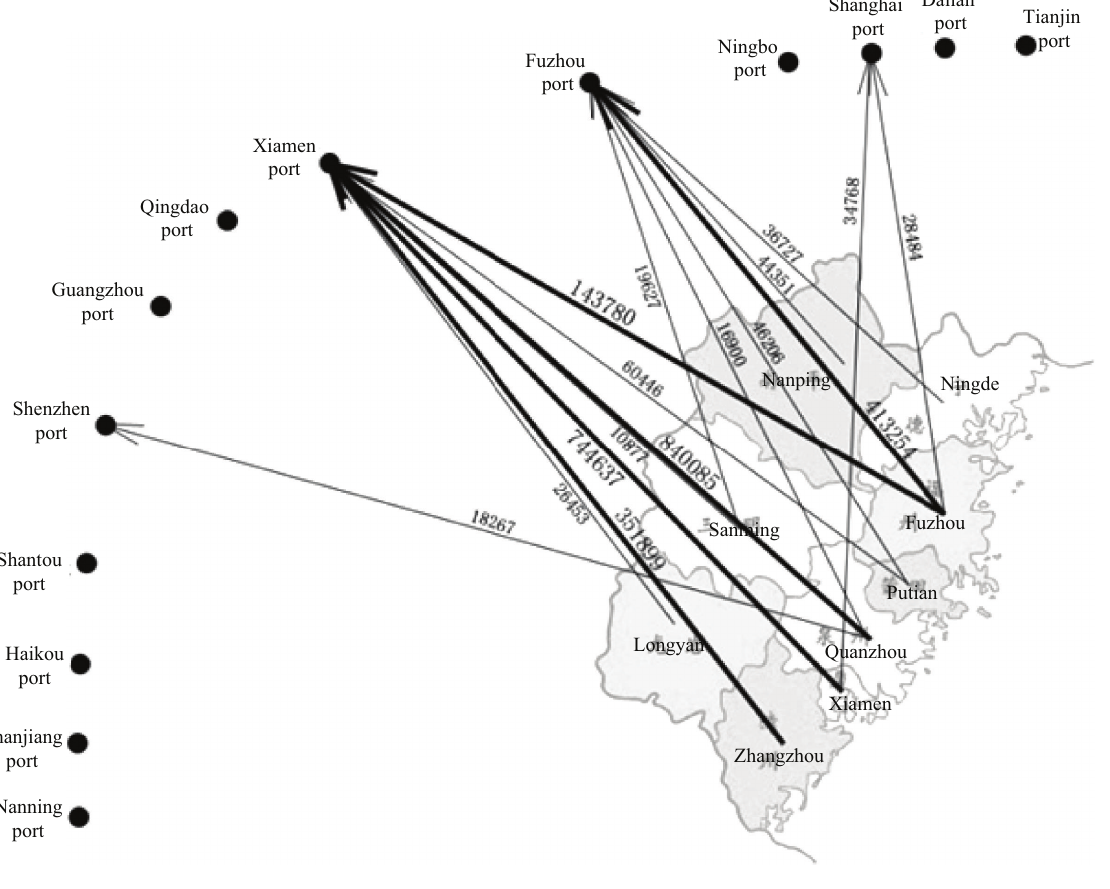
Figure 3: Export freight volumes between cities in Fujian province and various